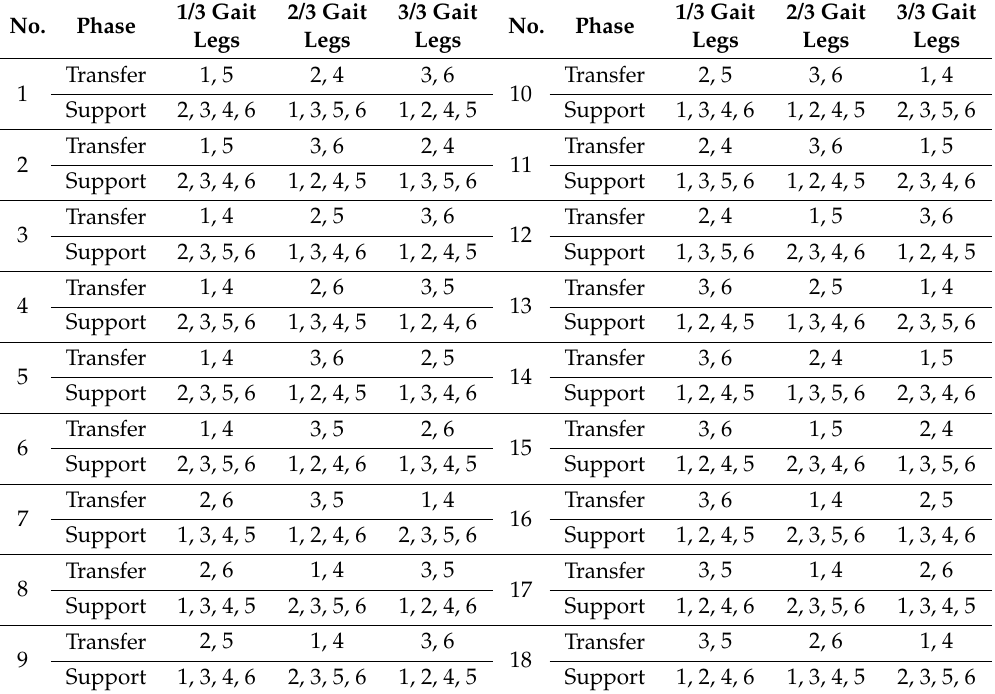
Table 1. Higher ‐ stable swing sequences of legs under quadrangular gait. Table 1. Higher-stable swing sequences of legs under quadrangular